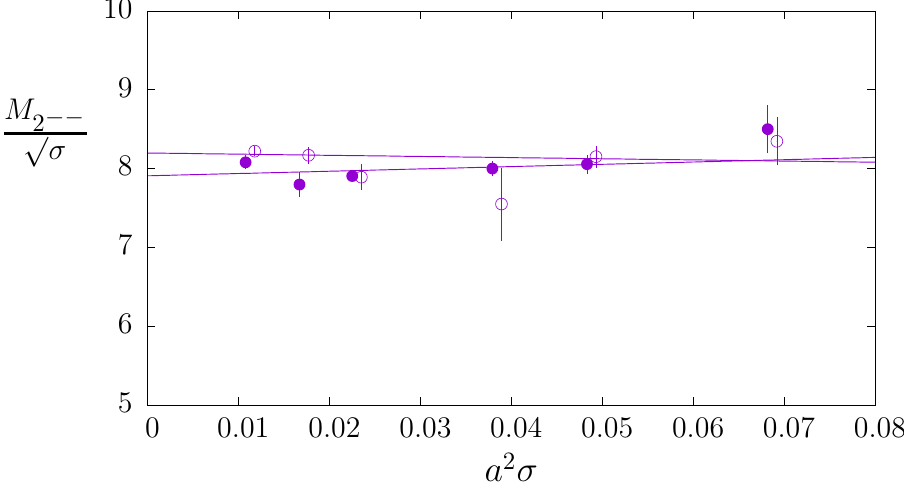
Figure 23 . Continuum extrapolation of the lightest J PC = 2 −− glueball, as obtained from the lightest E −− state ( • , doubly degenerate) and the lightest T 2 −− state ( ◦ , triply degenerate). Hence the five components of the two J = 2 state.